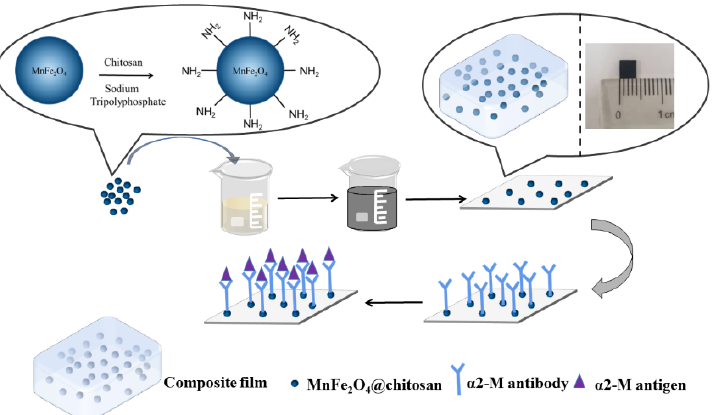
Figure 2. Schematic diagram for fabrication of MnFe 2 O 4 @chitosan/MWCNTs/PDMS composite film.